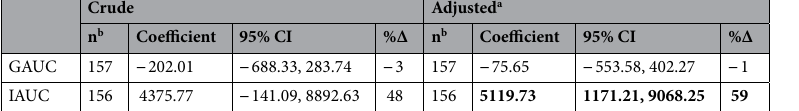
Table 4. Association between WSD and third-trimester GAUC and IAUC among subsequent study pregnancies (n = 159). WSD, western-style diet; CI, confidence interval; GAUC, glucose tolerance test area under the curve; IAUC, insulin area under the curve. a Adjusting for age and parity. b Sample size differs from 159 due to missing either GAUC or IAUC measurement. The bold indicates significantly different values from the reference group.